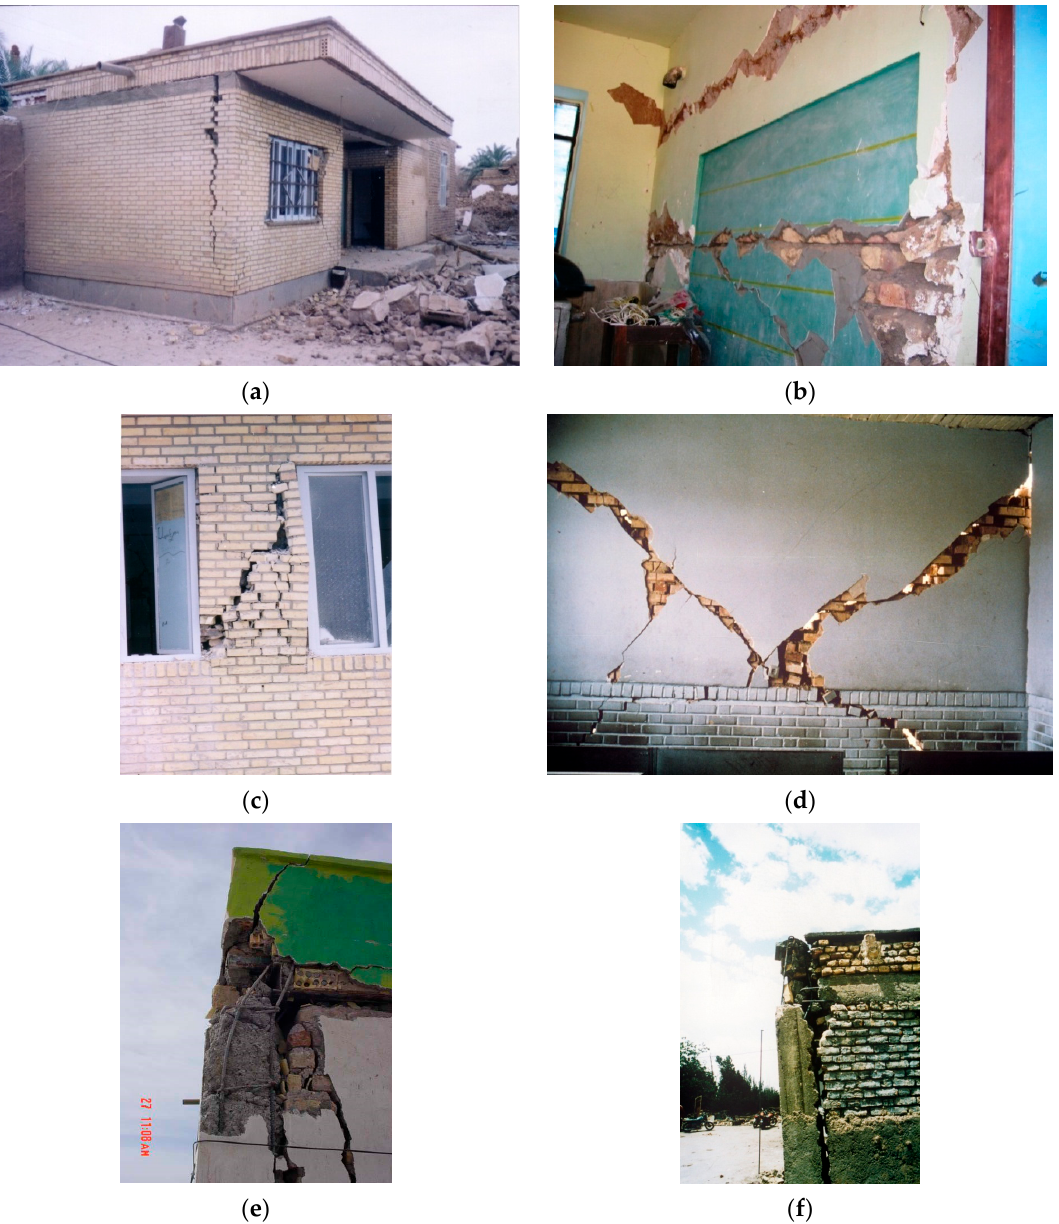
Figure 2. Common failure modes of masonry buildings in Iran [32]; ( a ) Detachment of perpendicular walls—damage at the interface of the walls (often occurs in URM buildings); ( b ) Horizontal in-plane cracks—damage in masonry walls (common in URM and CM buildings); ( c ) Stepped-diagonal cracks in the piers—damage in masonry walls (common in URM and CM buildings; if occurs in CM buildings, it propagates into RC vertical ties); ( d ) Stepped-diagonal cracks in solid walls—damage in masonry walls (common in URM and CM buildings; if occurs in CM buildings, it propagates into RC vertical ties); ( e ) Shear damage at the ties’ intersection due to insufficient shear reinforcement—damage in RC ties, often vertical ties (only in CM buildings); ( f ) Flexural failure at ties’ intersection due to inadequate overlapping of the longitudinal reinforcement of horizontal and vertical ties—damage at intersection of RC ties (only in CM buildings).